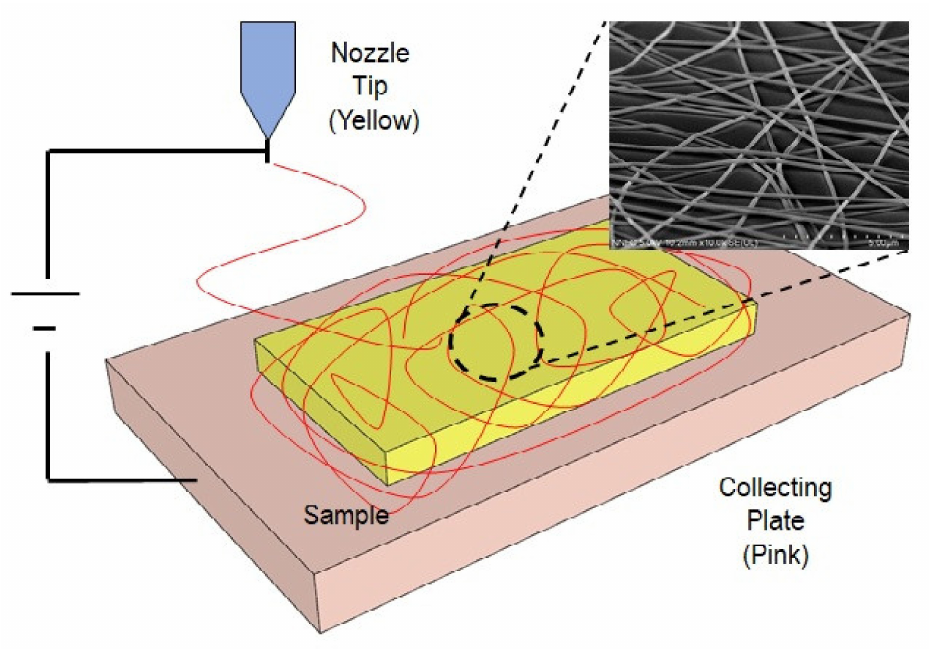
Figure 1. Schematic diagram of the electrospinning process to produce randomly distributed electro- spun